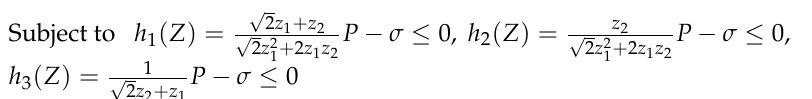
Table 9. Evaluation indicators and variable values for Figure 11.